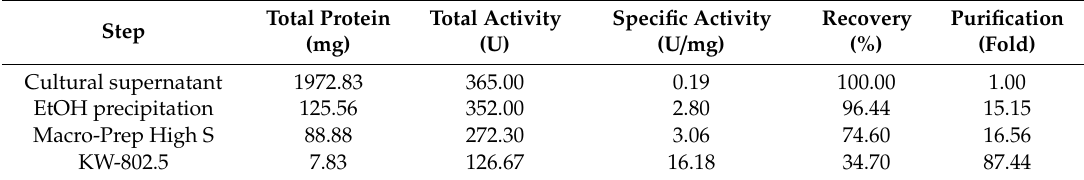
Table 1. Purification of Paenibacillus sp. TKU047 protease.